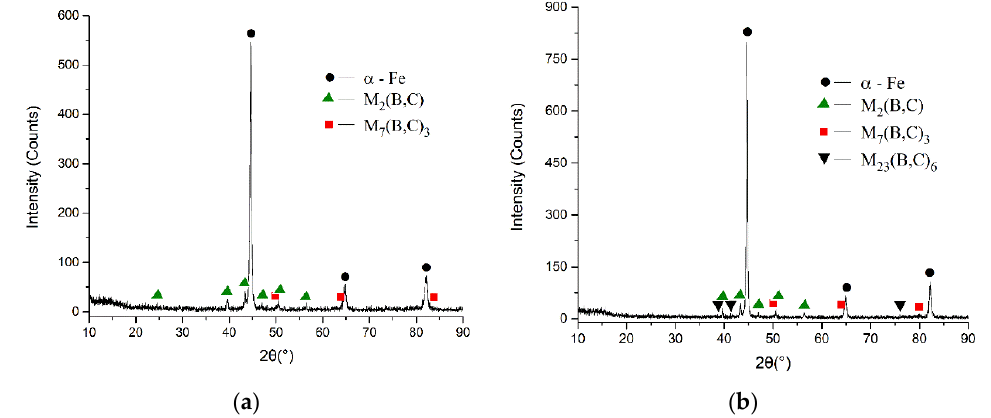
Figure 3. The as-cast microstructure and EDS analyses of boron-bearing stainless steel: ( a ) the microstructure morphology of as-cast boron-bearing stainless steel; ( b ) displaying microstructure morphology of A area: C-borocarbide [M 2 (B,C)], E- matrix; ( c , d ) displaying the distributions of chromium and nickel elements along black line in ( b ), respectively; ( e ) displaying the morphology of B area: D-borocarbide [M 7 (B,C) 3 ], E-matrix; ( f , g ) displaying the distributions of chromium and nickel elements along black line in ( e ), respectively.